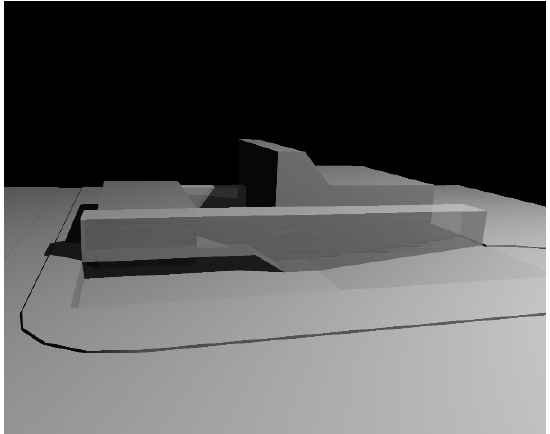
Figure 1. Concept massing model for the first design iteration facing Sheppard Avenue (Credit: Larkin Architect Limited).